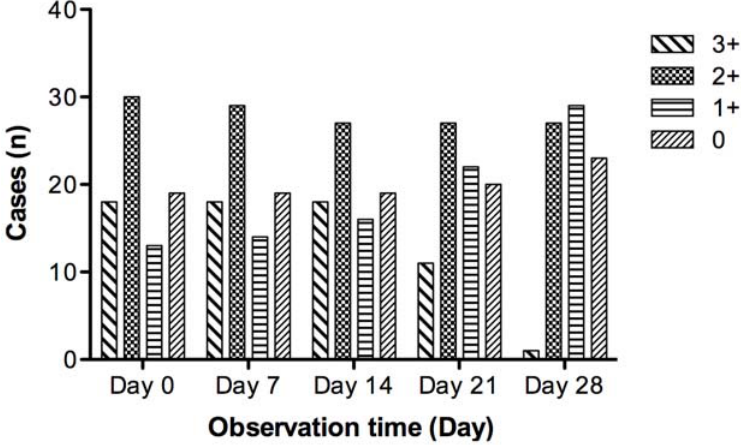
Figure 3. The distribution of different QDs fluorescent scales by